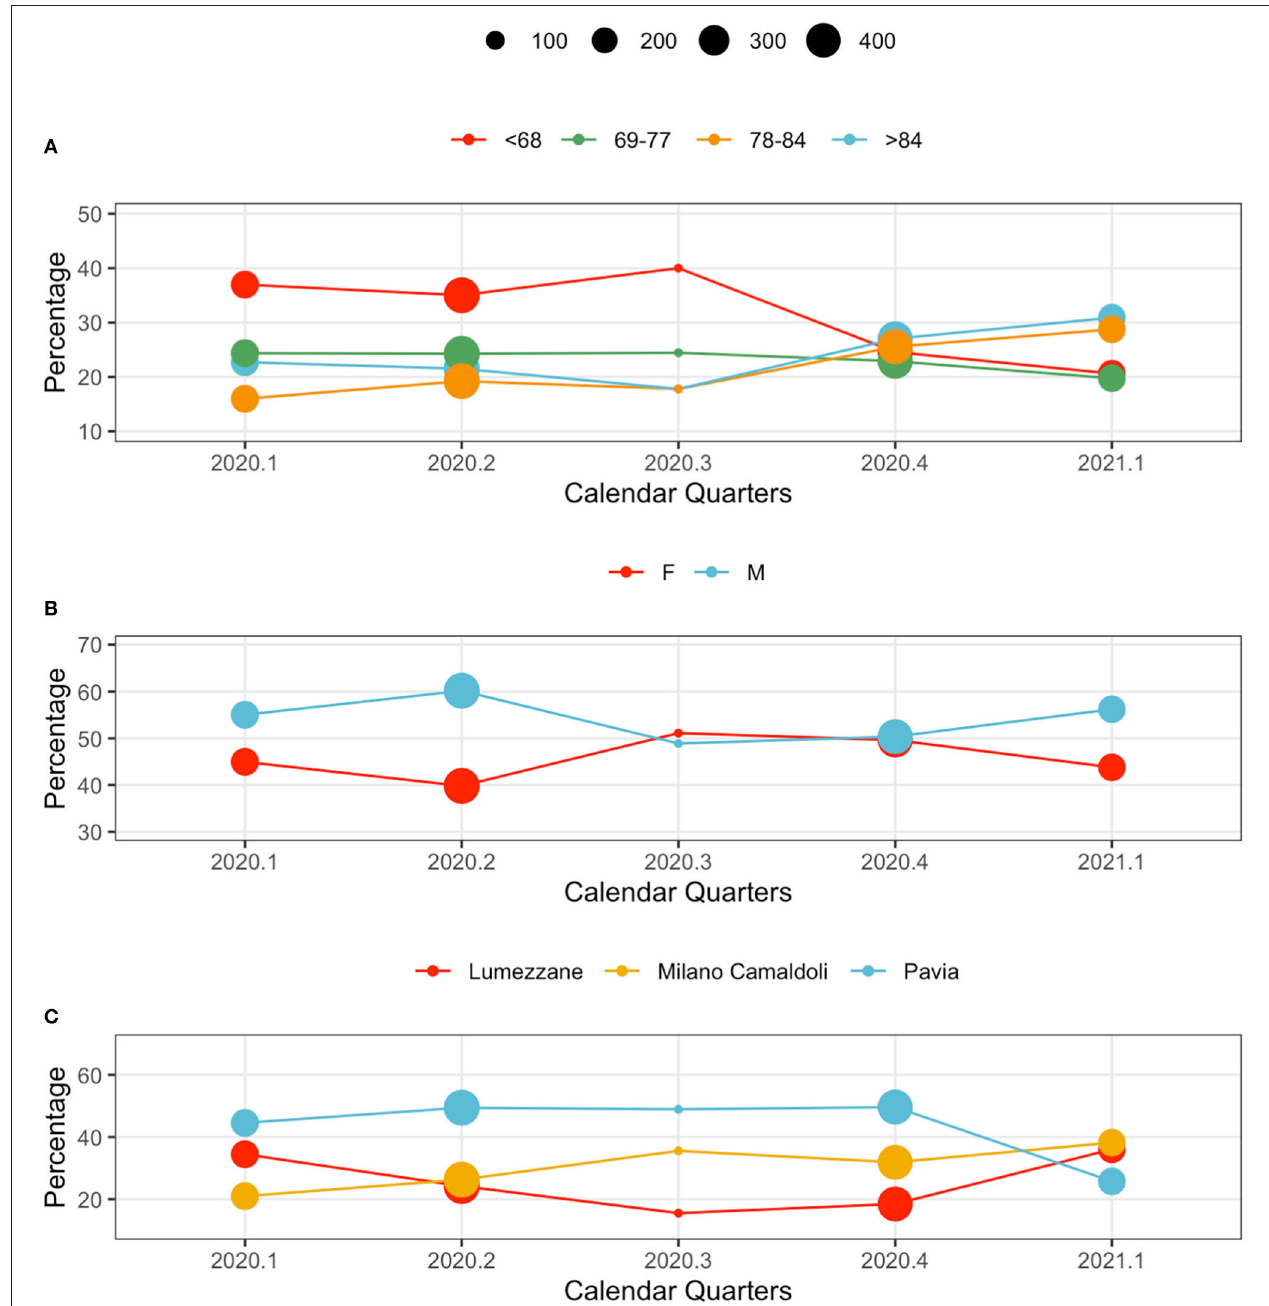
FIGURE 2 | Population characteristics in calendar quarters. From the top: (A) age classes, (B) sex, and (C) centers. The dot size indicates the total number of patients hospitalized in the quarter. The y axis reports the relative frequency (%) of each variable’s values by calendar quarter.